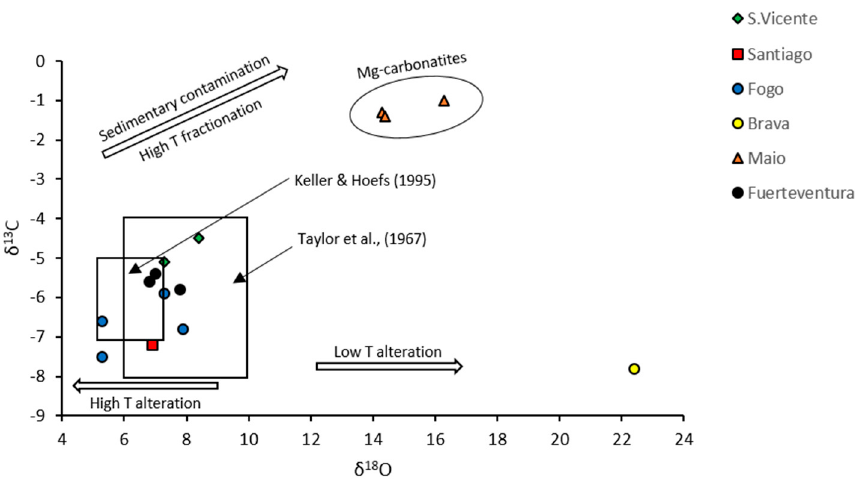
Figure 6. Stable isotope ( δ 13 C and δ 18 O) compositions (in ‰ relative to PDB and SMOW, respectively) of Fuerteventura and Cape Verde carbonatites. White arrows indicate possible post-emplacement changes in δ 13 C and/or δ 18 O values caused by secondary processes. Data from Hoernle et al. 2002 [20].